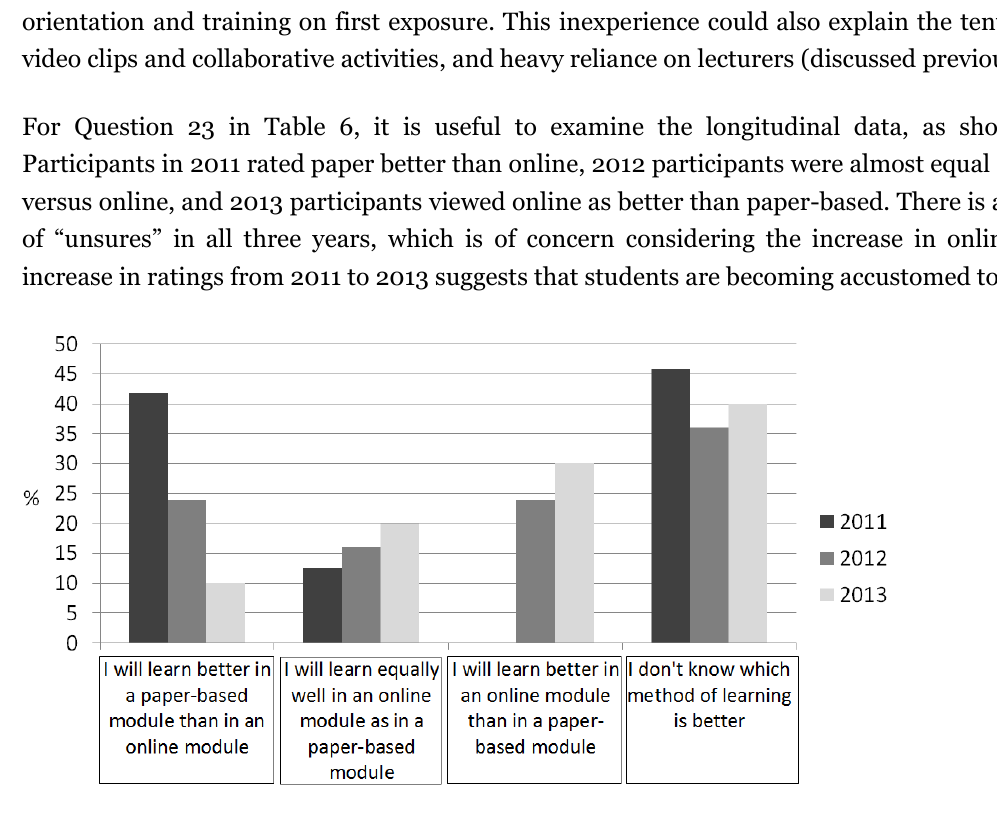
Figure 5. Longitudinal data suggests improvement in attitudes to online learning.